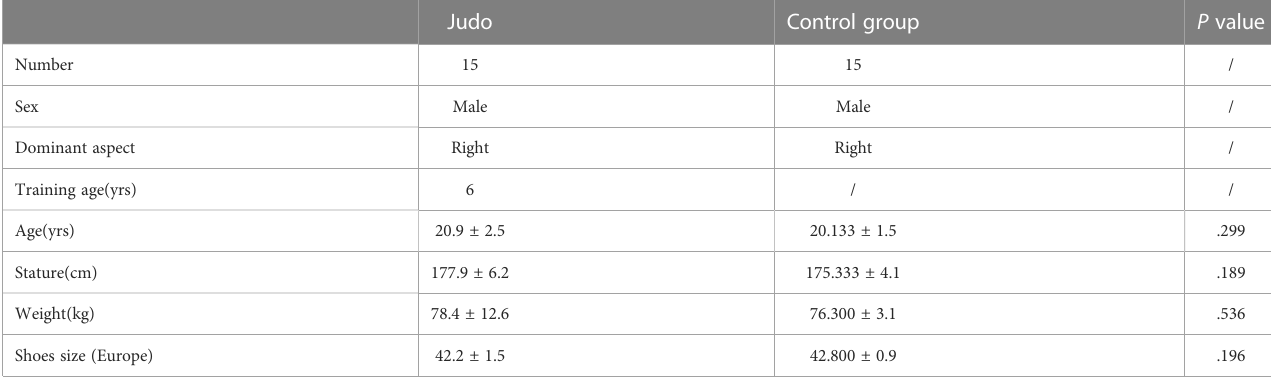
TABLE 1 Basic characteristics of judo and control